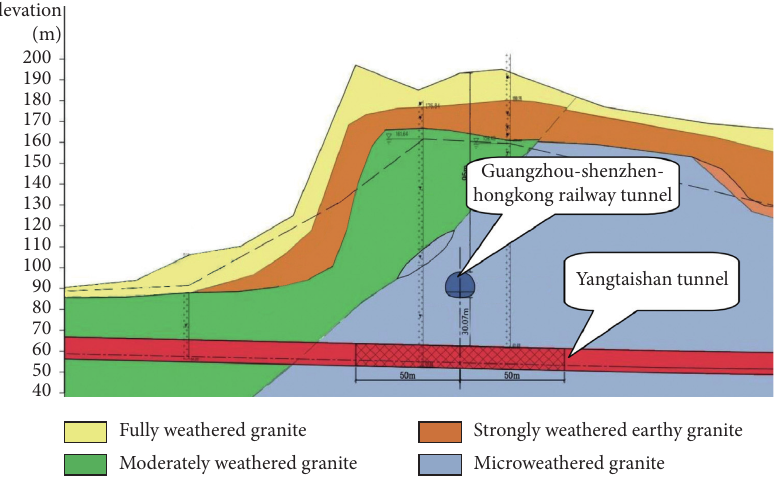
Figure 6: Vertical position of the two tunnels. Table 5: The observed values of evaluation indicators of the railway Table 6: Membership degrees of the eight evaluation indicators. tunnel.